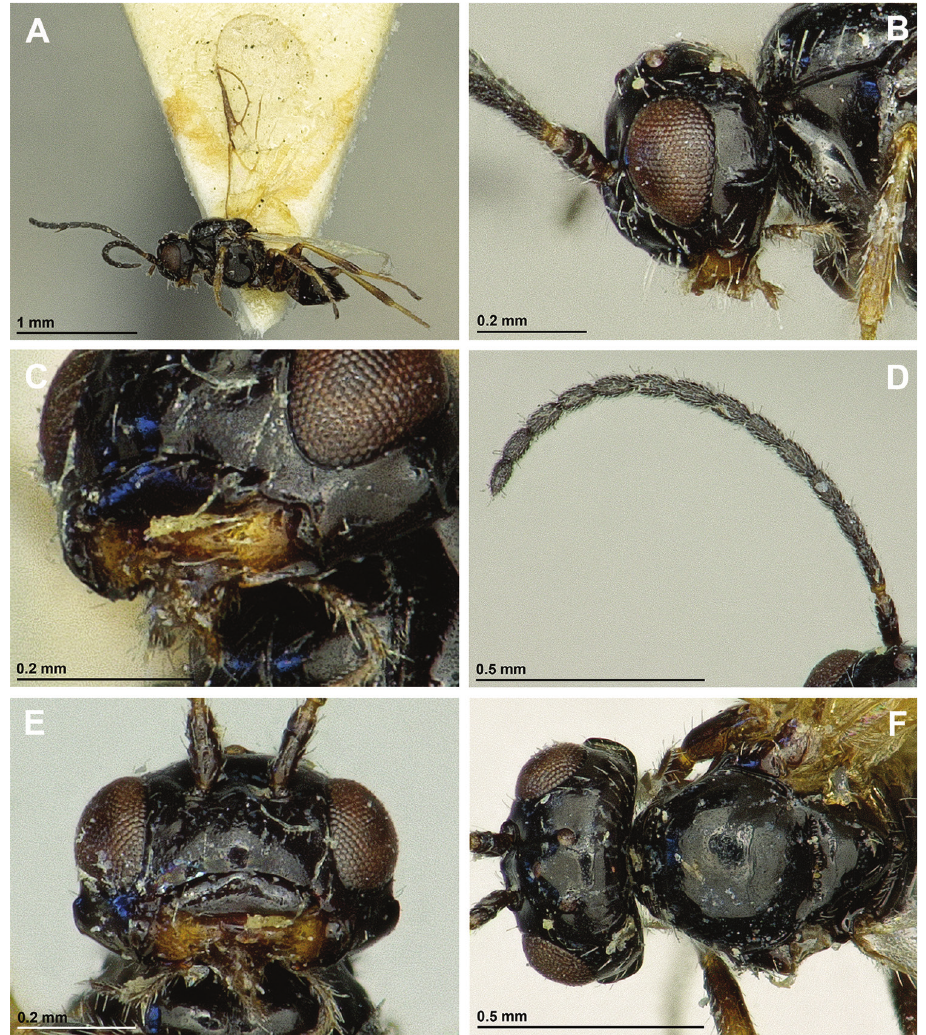
Figure 3. Hoplocrotaphus mongolicus Fischer, 1971 (female, holotype) A Habitus, lateral view B Head, lateral view C Mandible D Antenna E Head, front view F Head and mesoscutum, dorsal